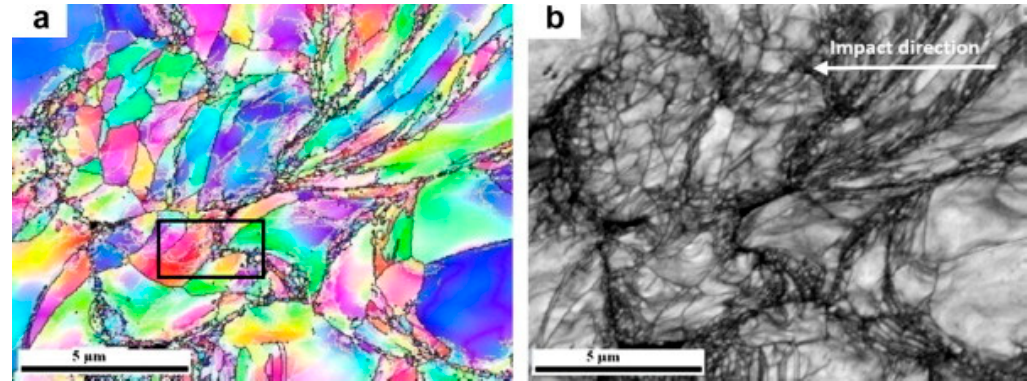
Figure 13. EBSD mappings of the cross-section of as-sprayed nickel coating: ( a ) Euler angle mapping and ( b ) pattern quality mapping of the same area as in ( a ) (adapted from reference [74], with permission from © Elsevier).